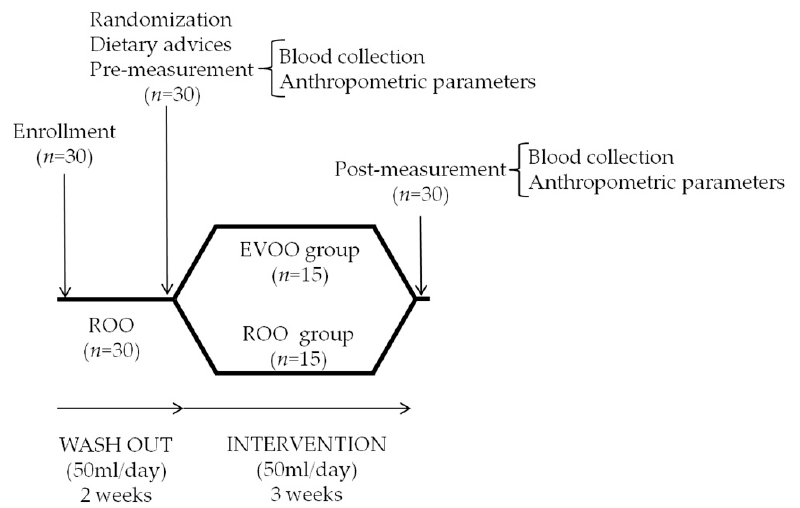
Figure 1. Study protocol. Note. EVOO: extra virgin olive oil; ROO: refined olive